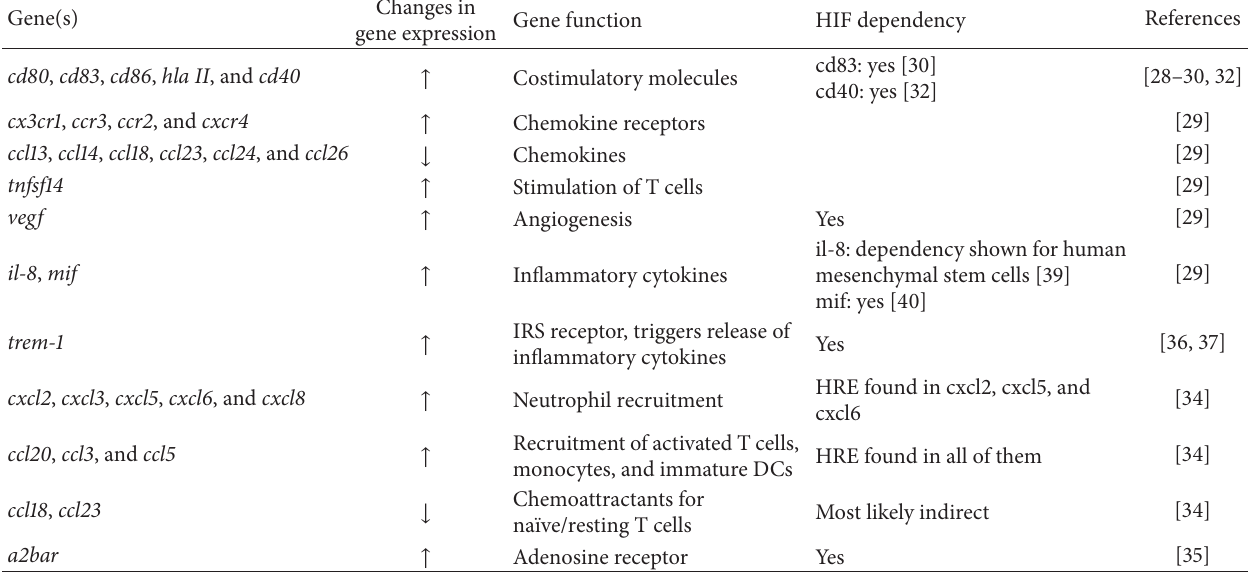
Table 1: Gene expression changes induced by hypoxia in human DCs.